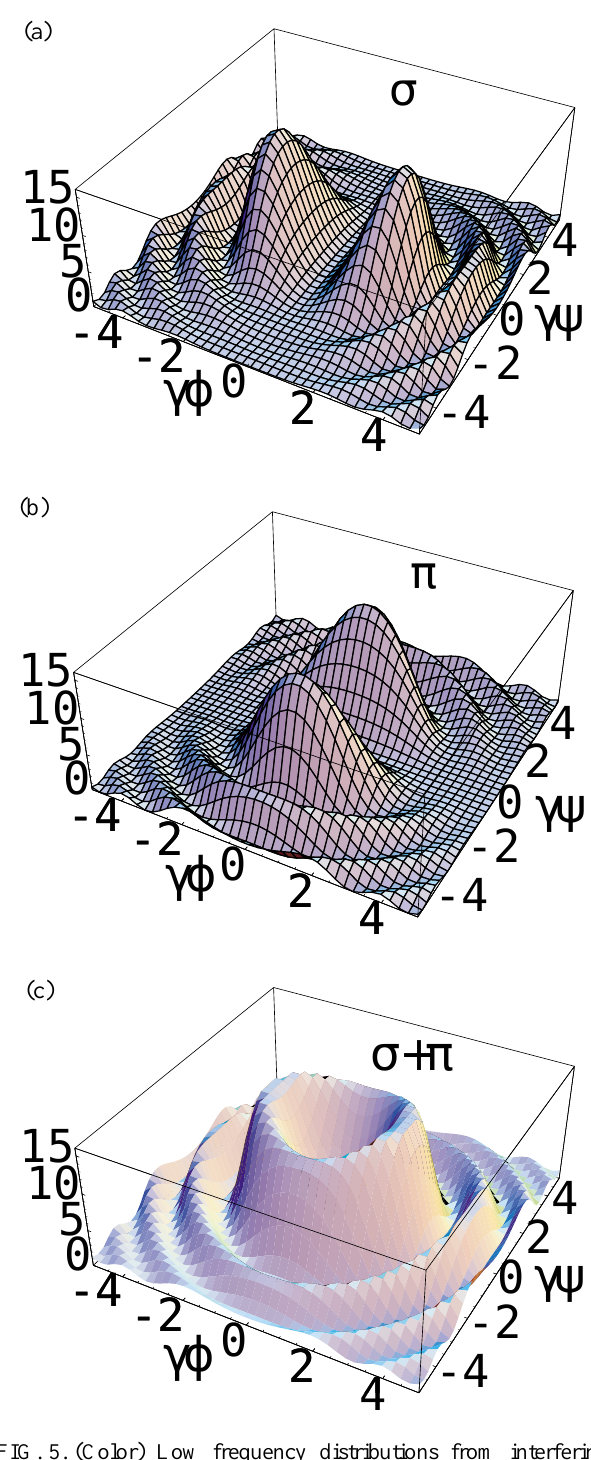
FIG. 5. (Color) Low frequency distributions from interfering dipole edges [Eq. (17)], normalized as in Fig. 1. The low fre- quency model reveals that the s 1 p density is not cylindrically symmetric, contrary to the strong field approximation [Eq. (20)]. that the symmetry observed in the electric field impulse schemed in Fig. 4 is preserved over a gw range of